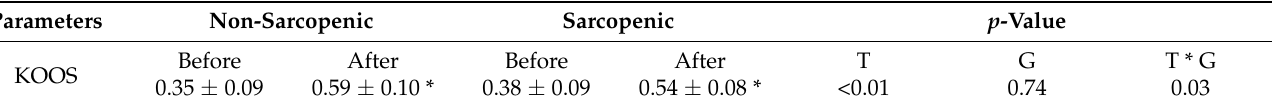
Table 2. Two-way ANOVA for repeated measures assessing the significance of time and sarcopenic and non-sarcopenic groups at KOOS before and after arthroplasty.